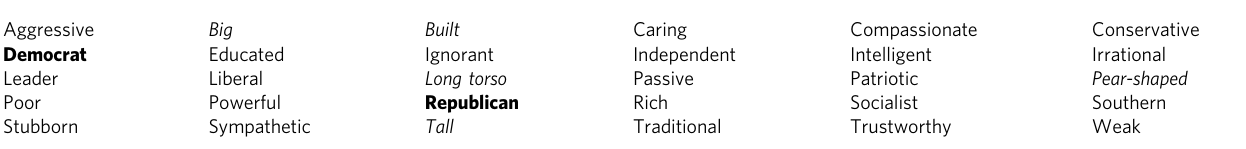
Table 1 List of political trait descriptors ordered alphabetically. Aggressive